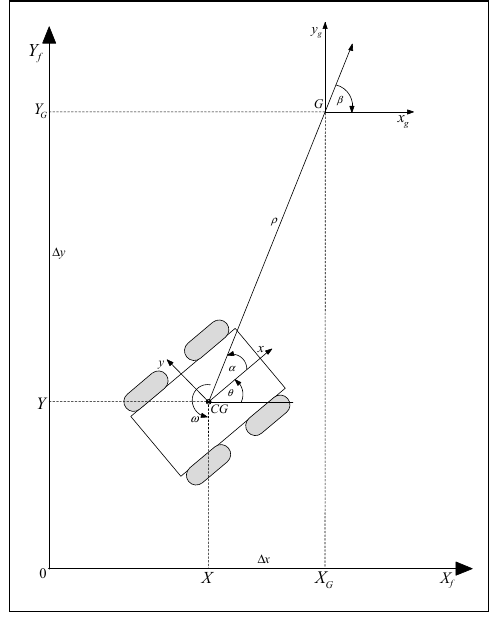
Figure 4. Kinematic control.